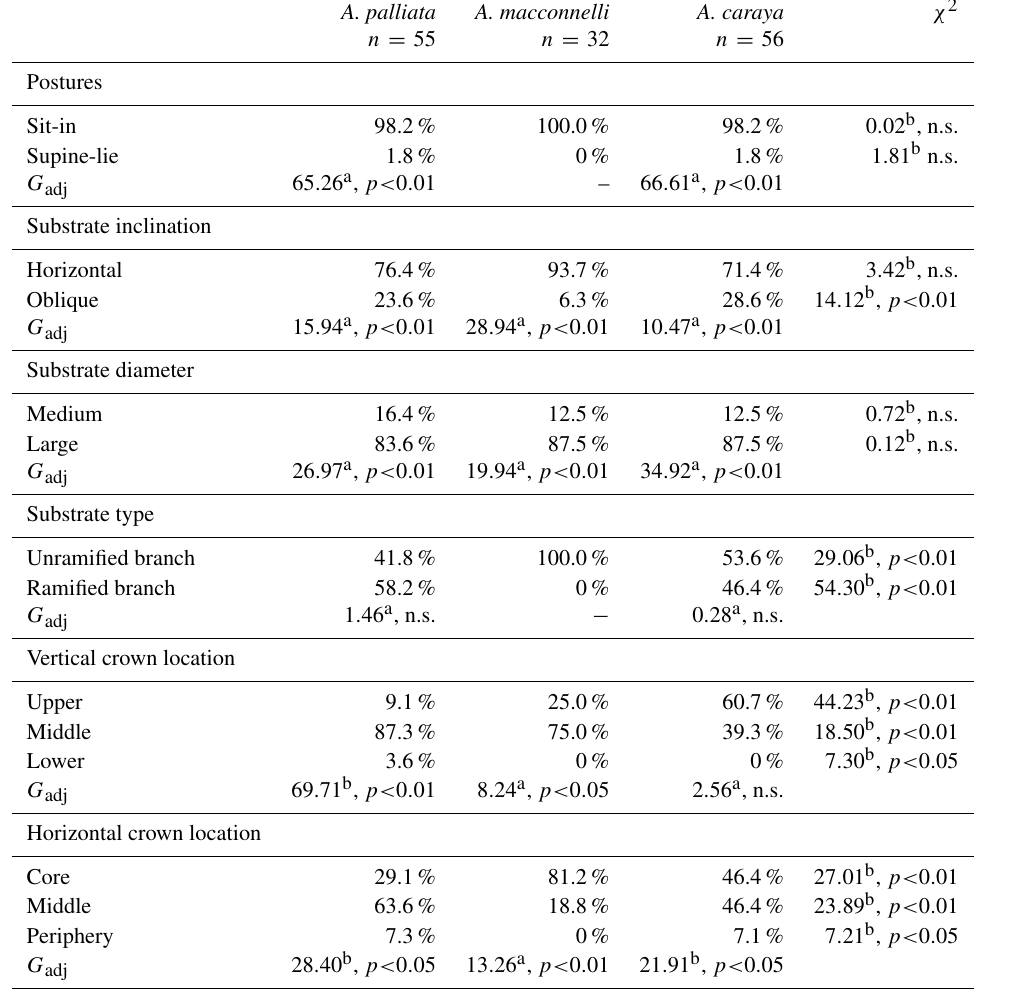
Table 1. Percentages of use of postures, substrate inclination, size and type, and crown location during sleep in three howler monkey